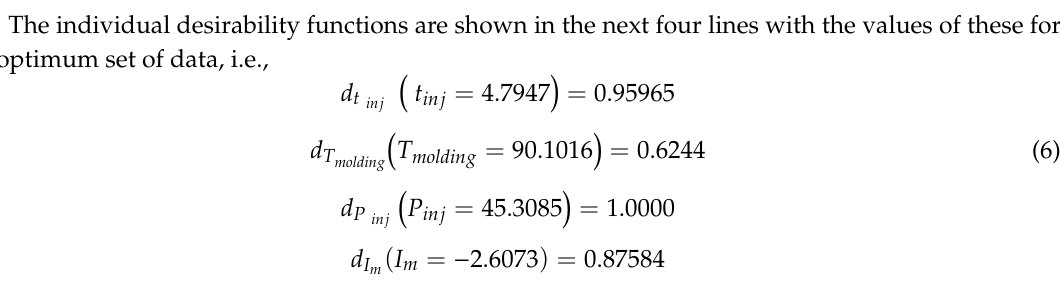
Table 3. Specified range of control factors (optimized process parameters) for Taguchi method. Control factor